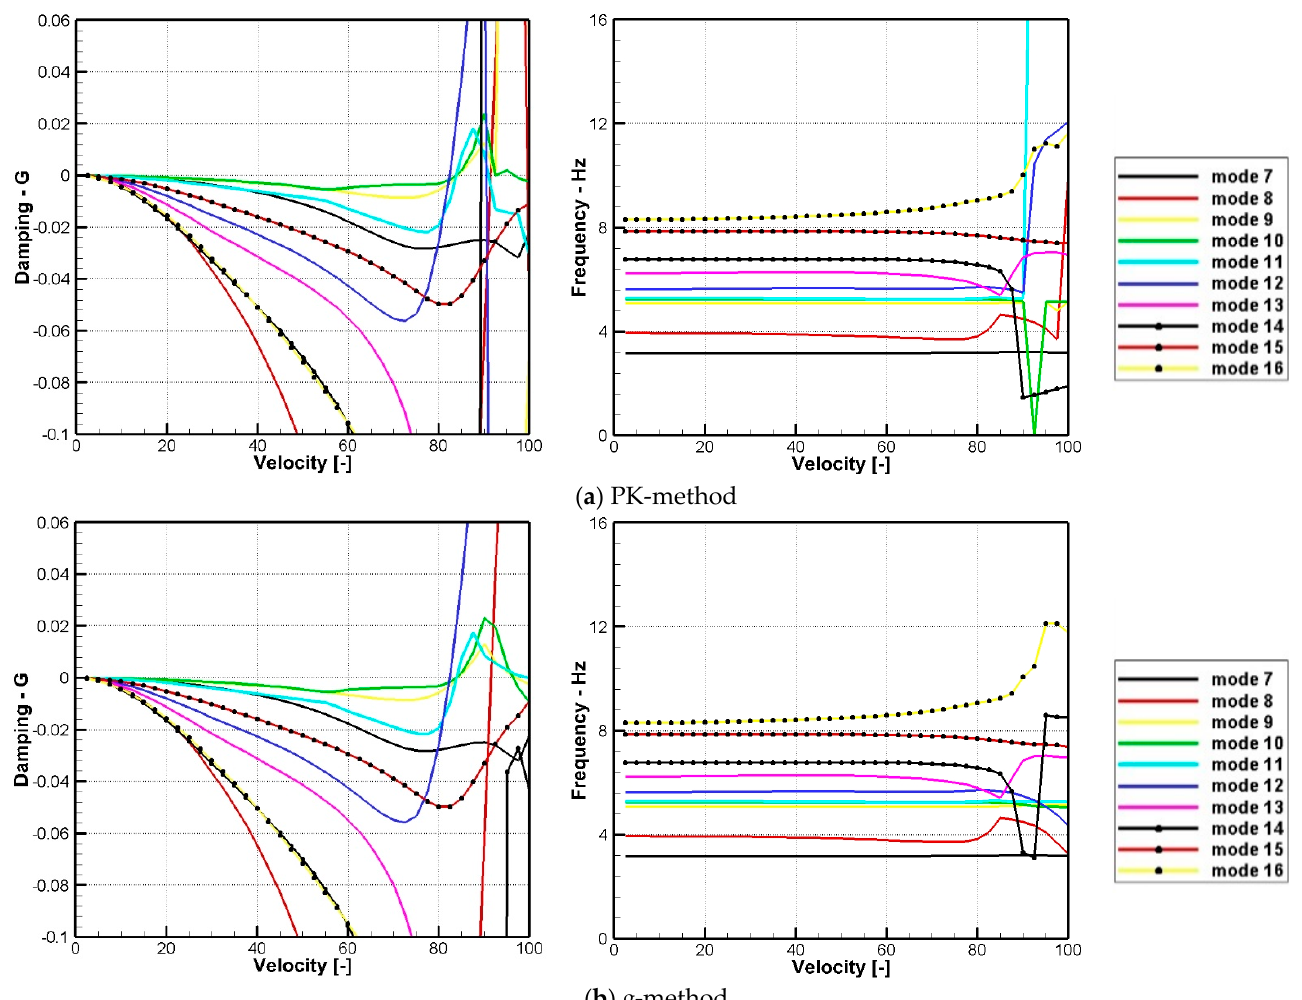
Figure 12. Results comparison between the FLUTQ g - and PK-methods for the Asymmetric 1 configuration of a real-world jet aircraft with velocities arbitrarily normalized.